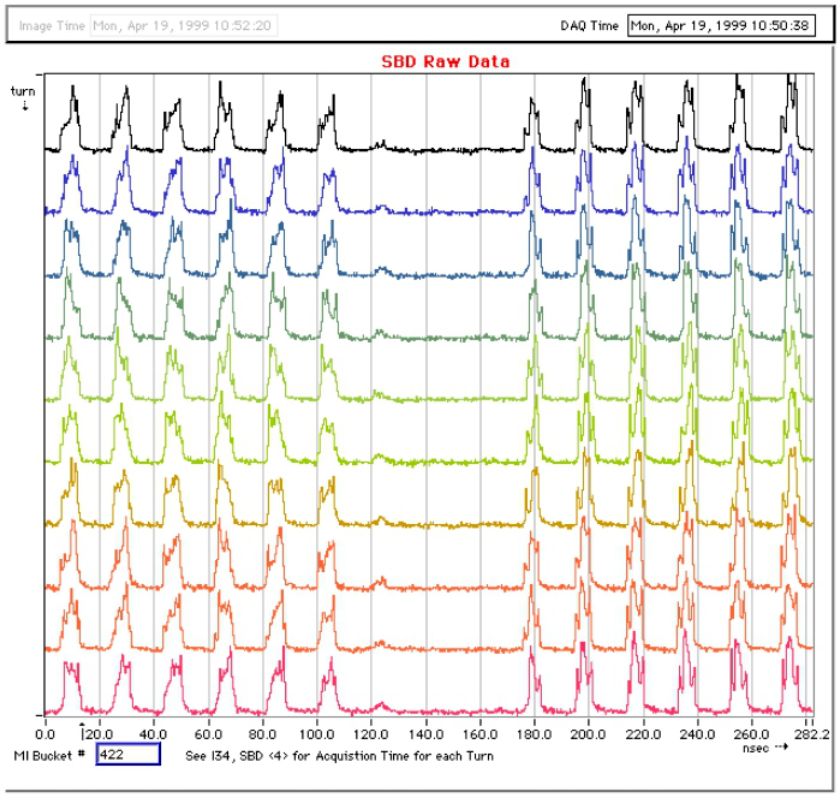
FIG. 8. (Color) The main injector bunches (cid:4) 30 ms after the injection of the sixth batch at 8-turn booster injection, corresponding to an intensity of about 2.4 3 10 10 protons per bunch. Consecutive traces are 12 turns (cid:2)(cid:4) 130 m s (cid:3) apart. Bunches directly from the booster seem to be clean and well